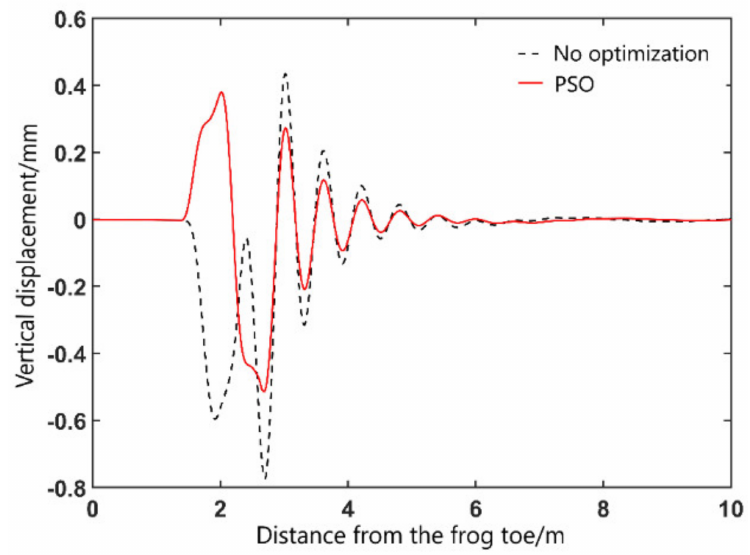
Figure 10. Wheelset vertical